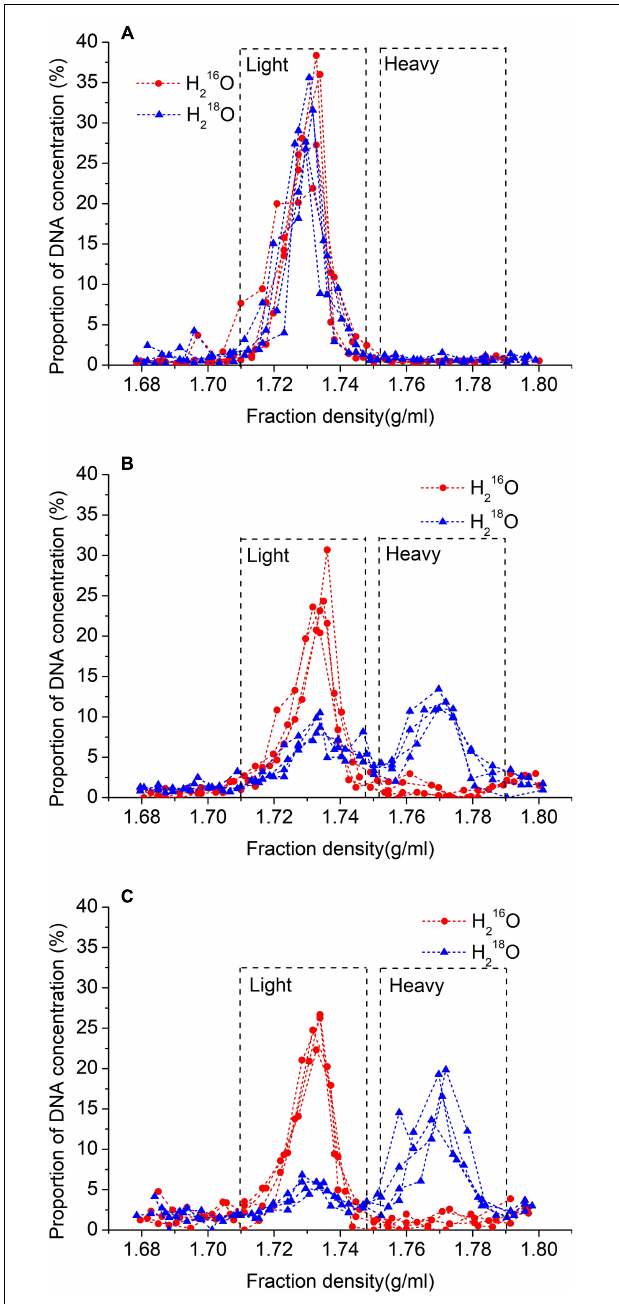
FIGURE 1 | Relationship between density of fractions and proportion of total DNA recovered after 30 days without microbial inoculation (A) , and 15 days (B) , or 30 days (C) with inoculation after ultracentrifugation. 18 O water replicates are represented by blue lines with triangles, and unlabeled replicates (control) are represented by red lines with